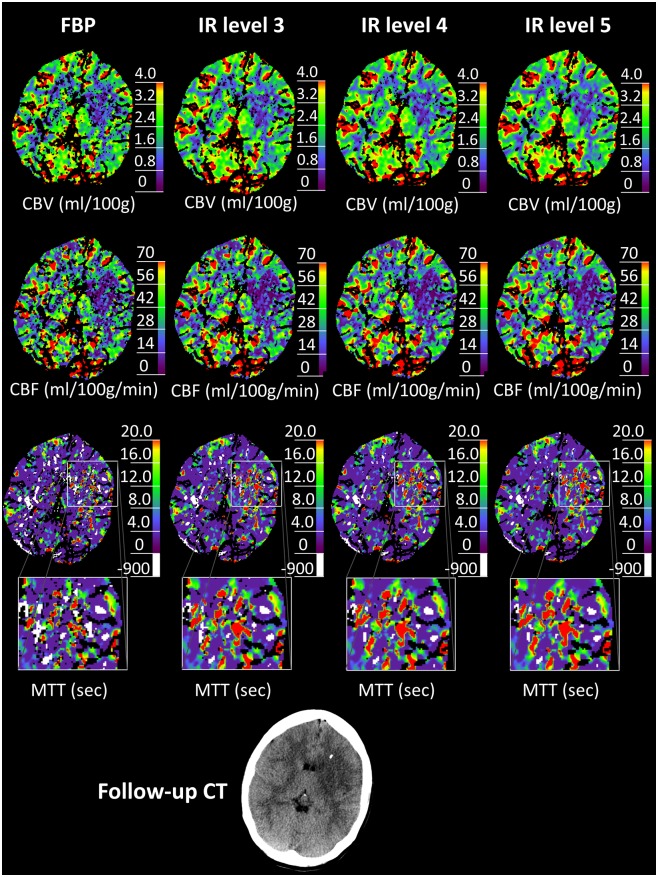
Example CTP images 2.In this case, the clinical decision differed from FBP (no relevant perfusion mismatch) to IR level 3–5 (visible relevant perfusion mismatch). While there was no change of the ischemic core visible in CBV, accentuated ischemic lesions became visible in CBF and MTT with increasing IR levels. In 4 of 23 cases, there was a change in the assessment of a perfusion mismatch.